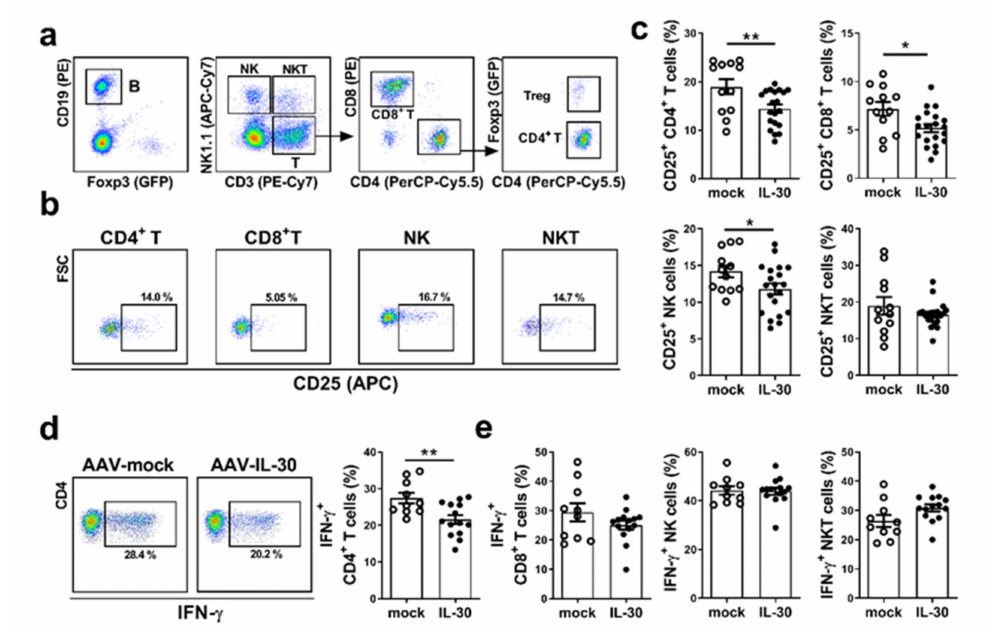
Figure 2. Administration of AAV-mIL-30 decreased the activation of CD4 + T cells in 2-OA-OVA-induced autoimmune cholangitis mice. Foxp3 GFP mice were injected with AAV-mIL-30 or AAV-mock at 3 weeks after the first 2-OA-OVA immunization and sacrificed at Week 5. Liver leukocytes were isolated. ( a ) Representative flow plots show gating strategies of different subsets of lymphocytes. ( b ) Representative flow plots show CD25 expression on CD4 + and CD8 + T cells, NK cells, and NKT cells. ( c ) The levels of CD25 expression on CD4 + and CD8 + T cells, NK cells, and NKT cells were analyzed using flow cytometry. ( d , e ) Liver leukocytes were stimulated with phorbol-myristate acetate (PMA) and ionomycin for 4 h, and IFN- γ production in cells was analyzed using intracellular staining and flow cytometry. ( d ) Representative flow cytometry analysis and graphical summary of the level of IFN- γ secretion in liver CD4 + T cells. ( e ) The levels of IFN- γ secretion in liver CD8 + T, NK, and NKT cells. Each dot represents an individual mouse. n = 12–20 mice per group. All error bars denote ± SEM. *, p < 0.05; **, p <